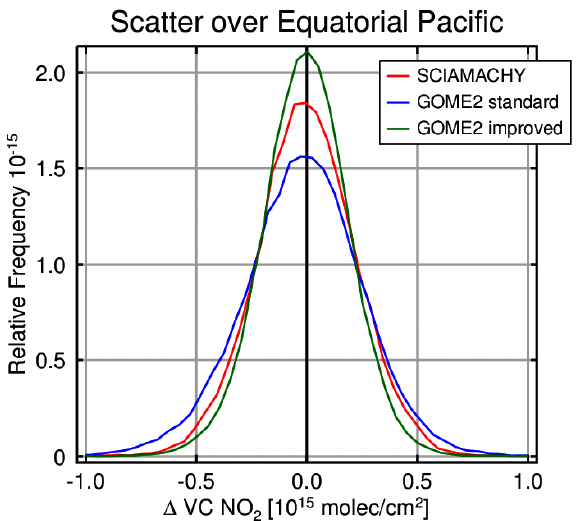
Fig. 2. Distribution of vertical NO 2 columns over a clean region at the equatorial Pacific (5 ◦ S–5 ◦ N, 150–210 ◦ E) for August 2007. A stratospheric airmass factor was applied, and only forward scans were included. All curves were normalised to have unit area and centred on 0. See text for details on the two different GOME-2